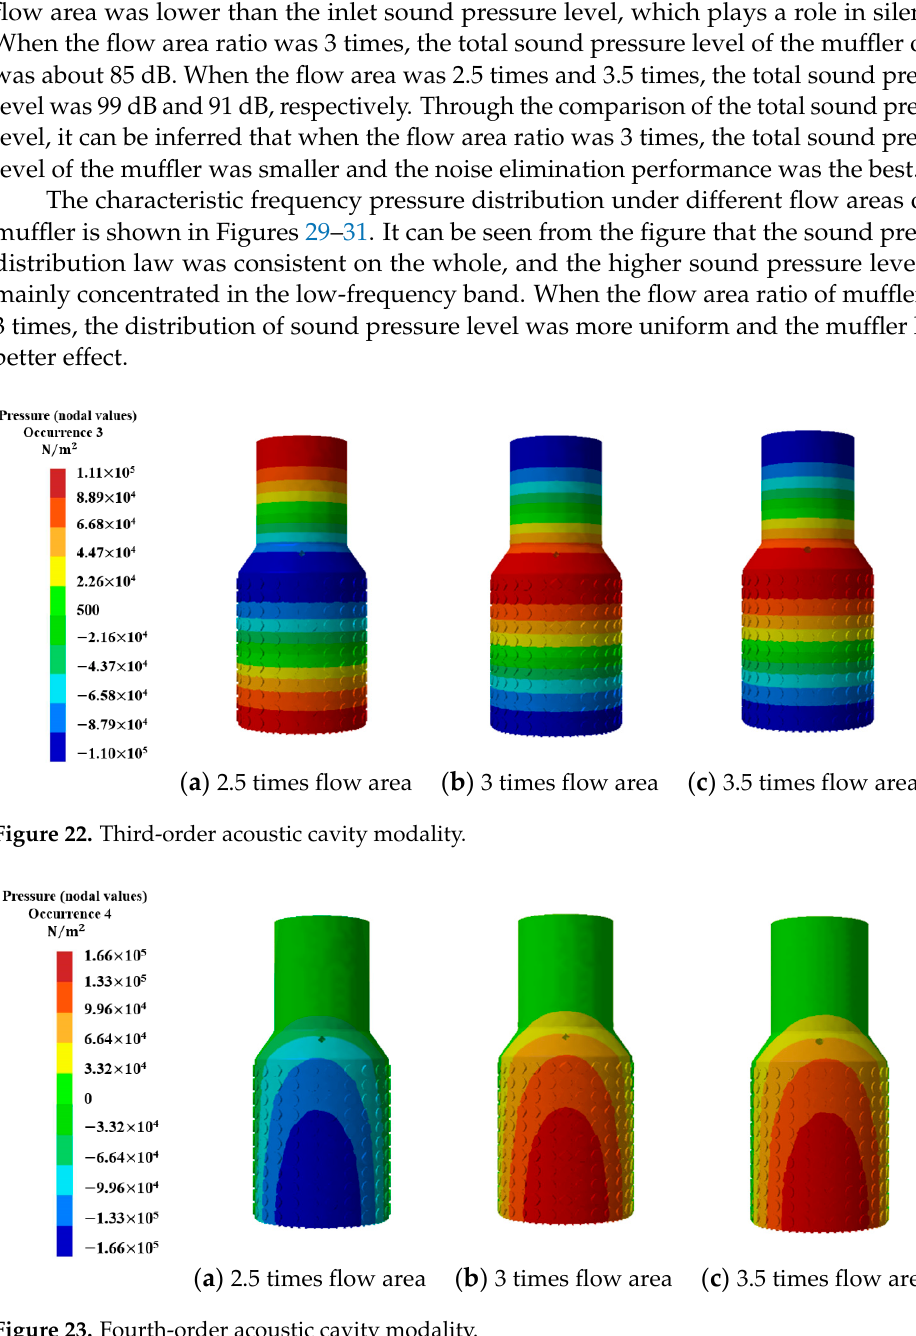
Figure 23. Fourth-order acoustic cavity modality.